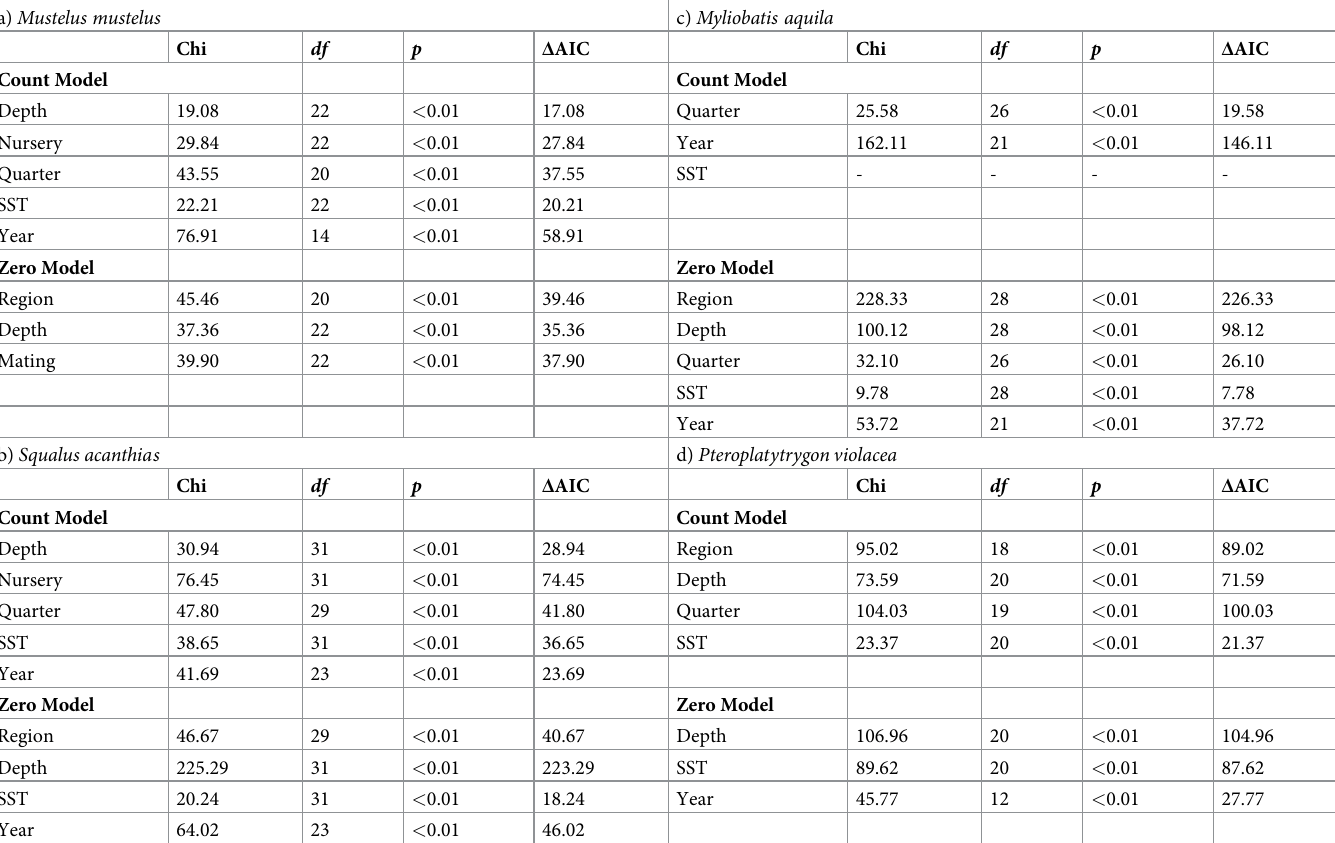
Table 3. Summary statistics of the explanatory variables of ZINB models of the four elasmobranch species: a) Mustelusmustelu s,b) Squalusacanthias ;c) Myliobatis aquila and d) Pteroplatytrigonviolacea . The table reports Chi 2 of likelihood ratio test, degree of freedom, p-value of the test and Δ AIC. Thick line indicates that dropping the variable, the model does not converge. a) Mustelus